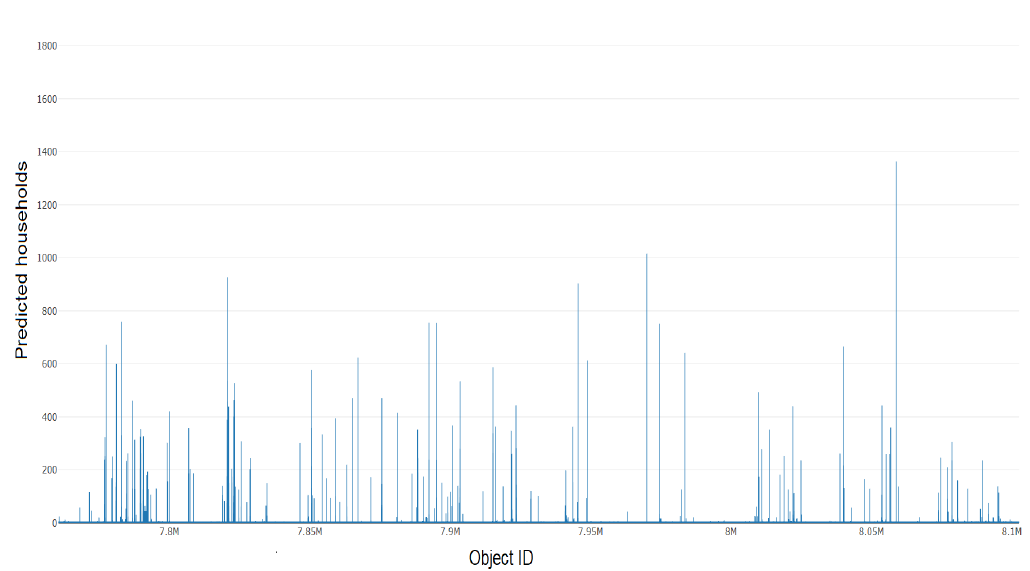
Figure 19. Bar-plot to signify the predicted households for year 30 based on Object-ID.